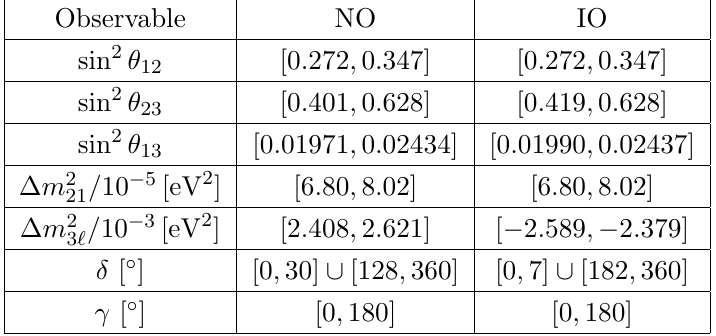
= (cid:1) m 2 > 0 for normal ordering (NO) and 31 3 ‘